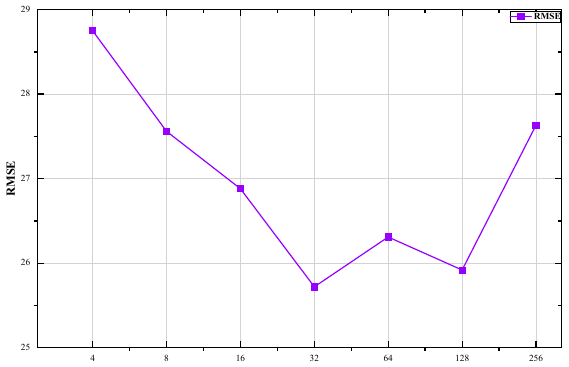
Figure 4. The RMSE distribution with different batch size.